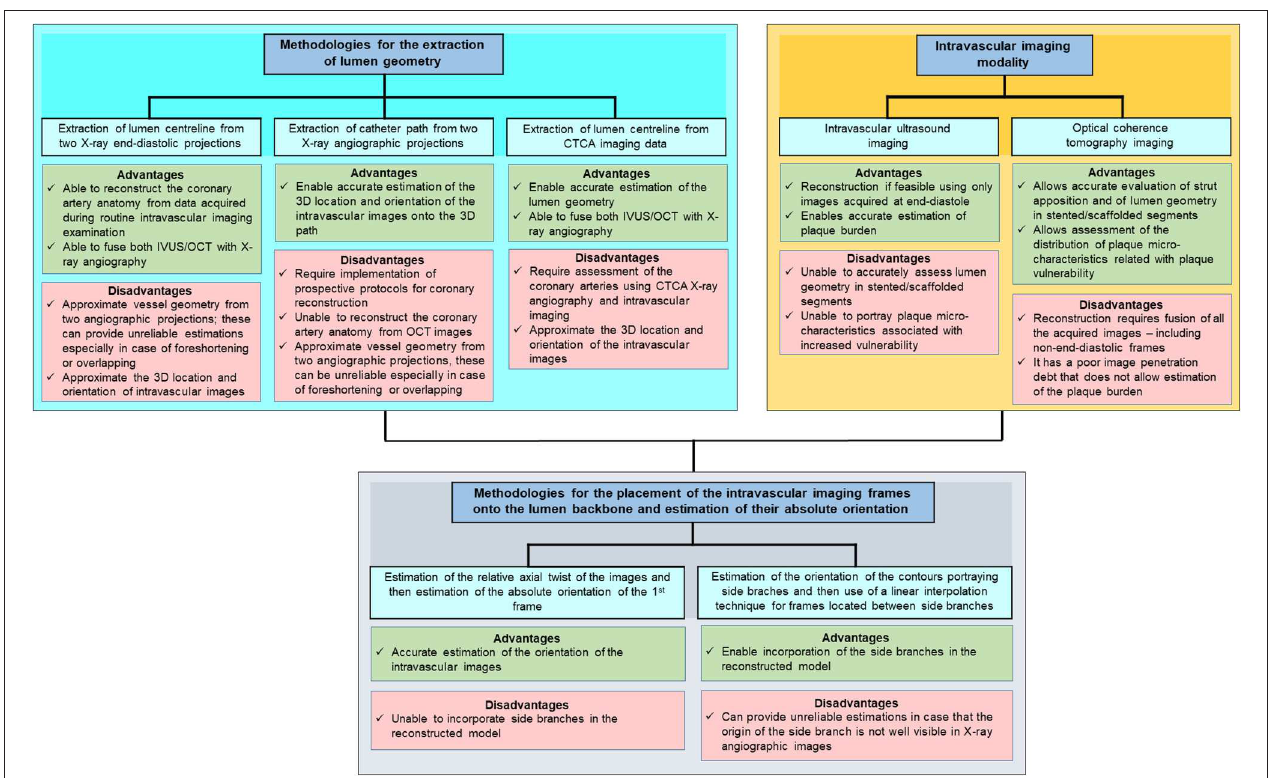
FIGURE 1 | Advantages and limitations of different intravascular imaging modalities and algorithms proposed in different reconstruction methodologies for the modelling of coronary artery